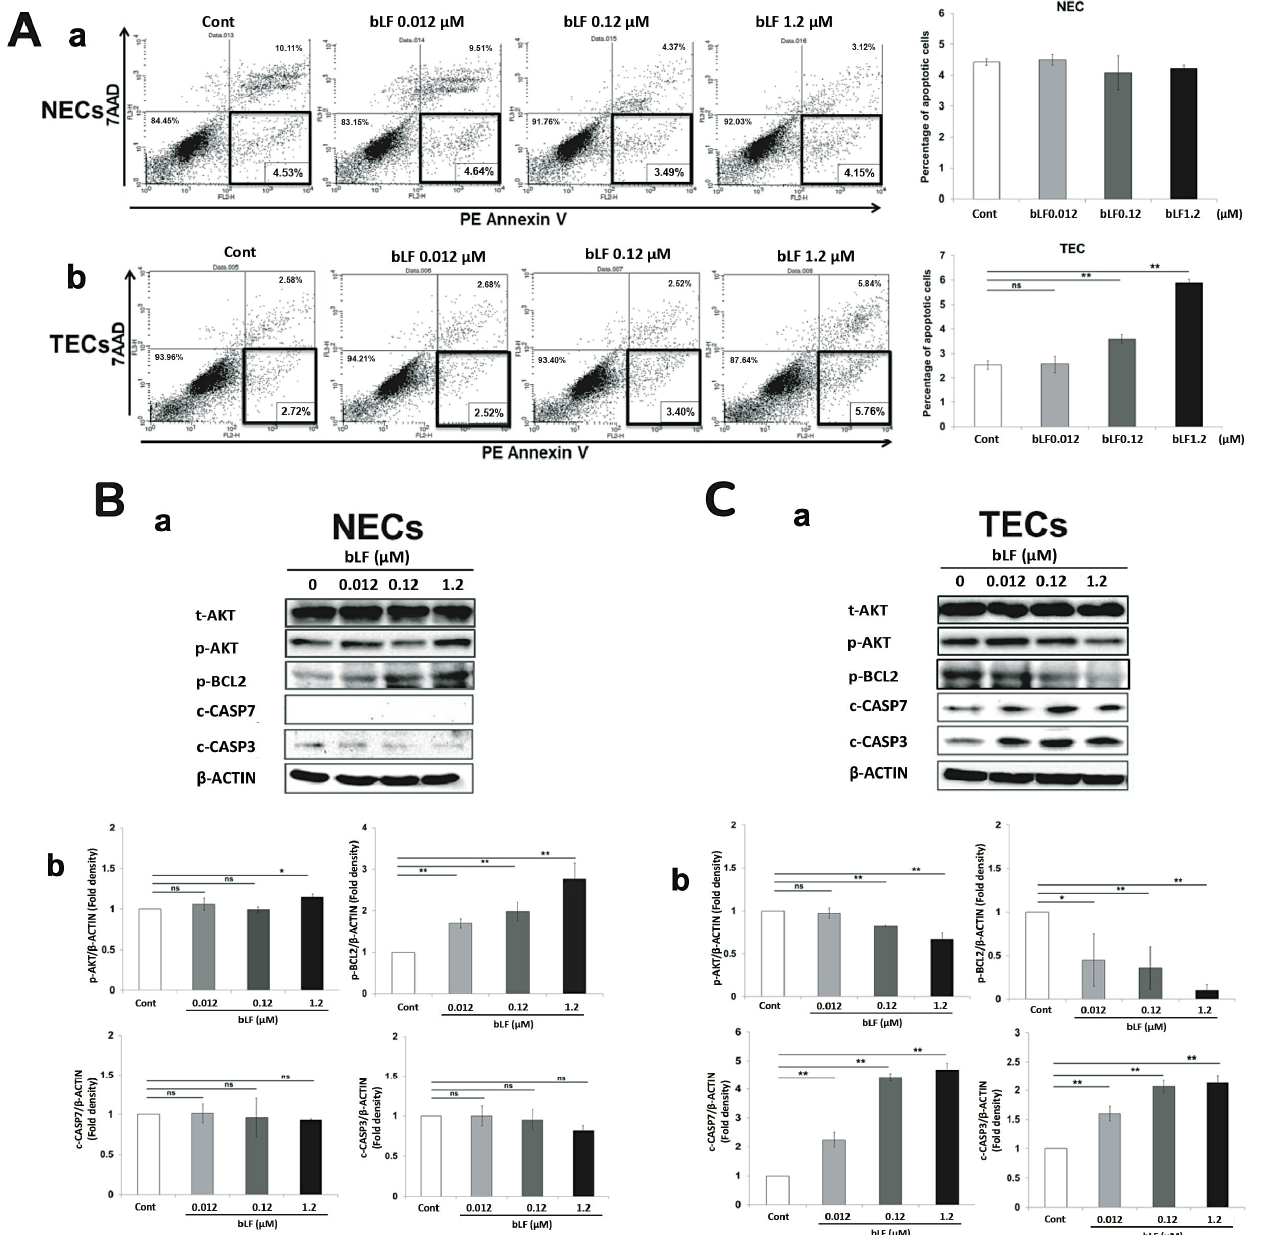
Figure 3. Effect of bLF on apoptosis of NECs and TECs. ( A ) The percentage of early apoptotic cells in NECs ( a ) and TECs ( b ). Effect of bLF on apoptosis-related proteins in TECs ( C ) and NECs ( B ). Both cells were cultured with bLF treatment (0.012, 0.12, 1.2 µM) for 3 days. Protein expression was analyzed by Western blotting ( a ). Semi-quantitative analysis was also conducted ( b ). Data quantification was performed using imageJ software (National Institutes of Health, US). Data represent the mean ± standard deviation (SD) of three-independent experiments, each performed in triplicate. Statistical significances were determined by one-way analysis of variance (ANOVA). ns: not significant; * p < 0.05, ** p <